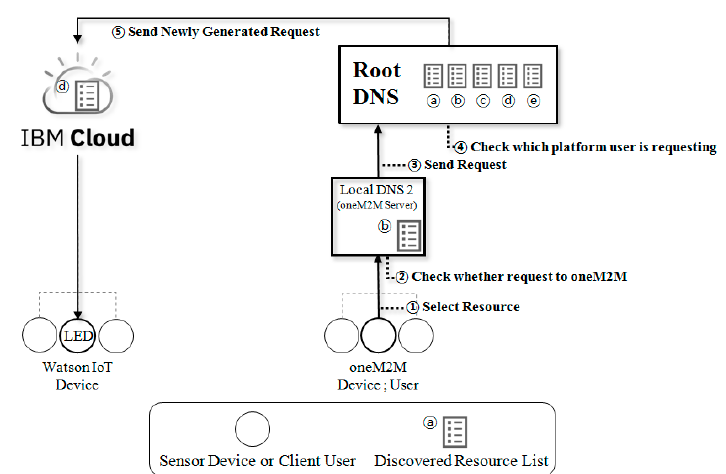
Figure 12. Scenario 1: A oneM2M request to a Watson IoT.